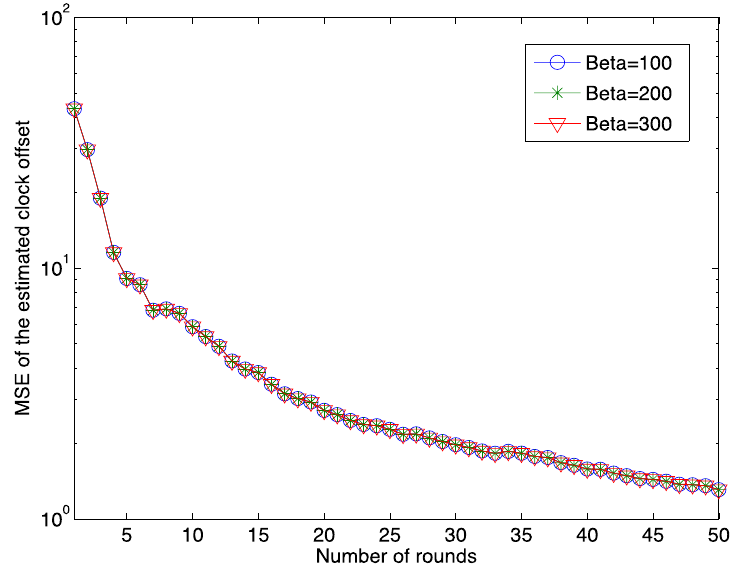
Figure 3. The MSE of the estimated offset as a function of the number of rounds for different initial clock offsets when μ = 5 μs and λ = 1.